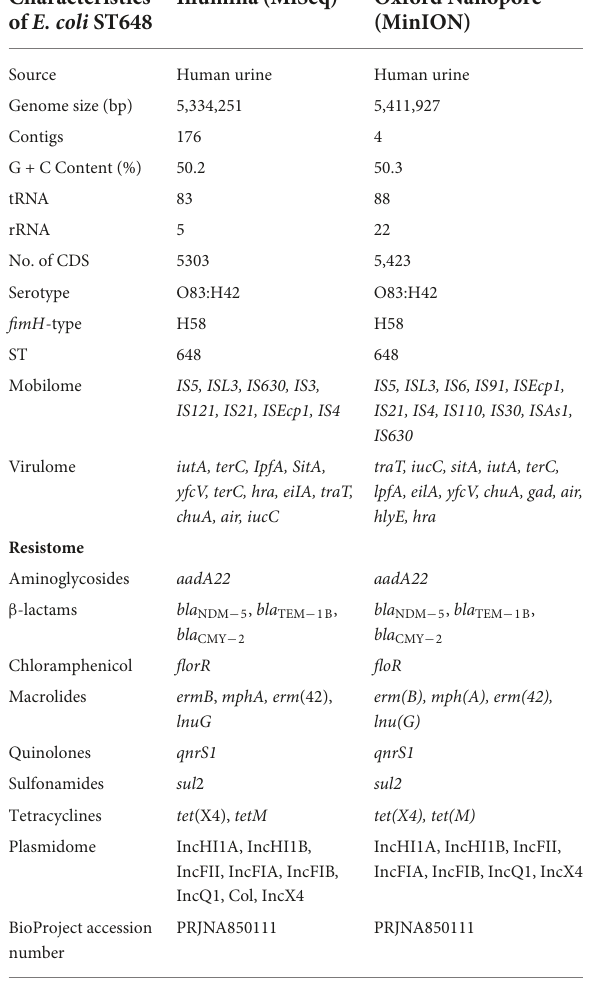
TABLE 1 Genomic characteristics of Escherichia coli ST648 strain isolated from human